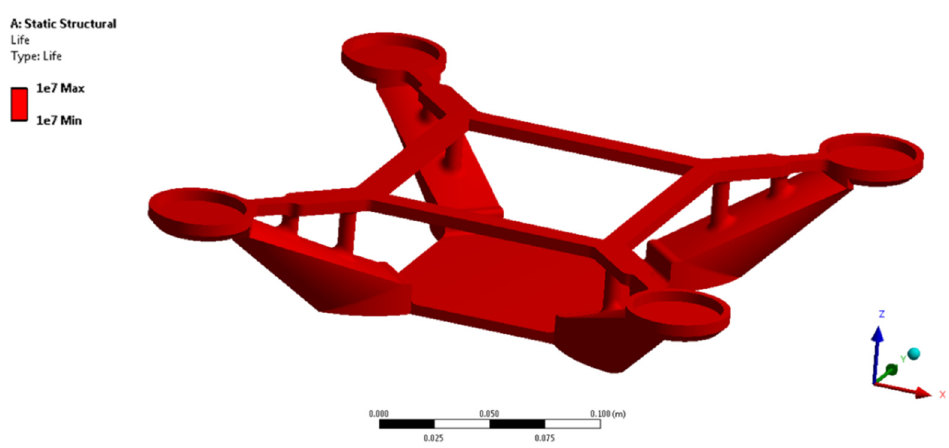
Figure 10. Fatigue analysis.